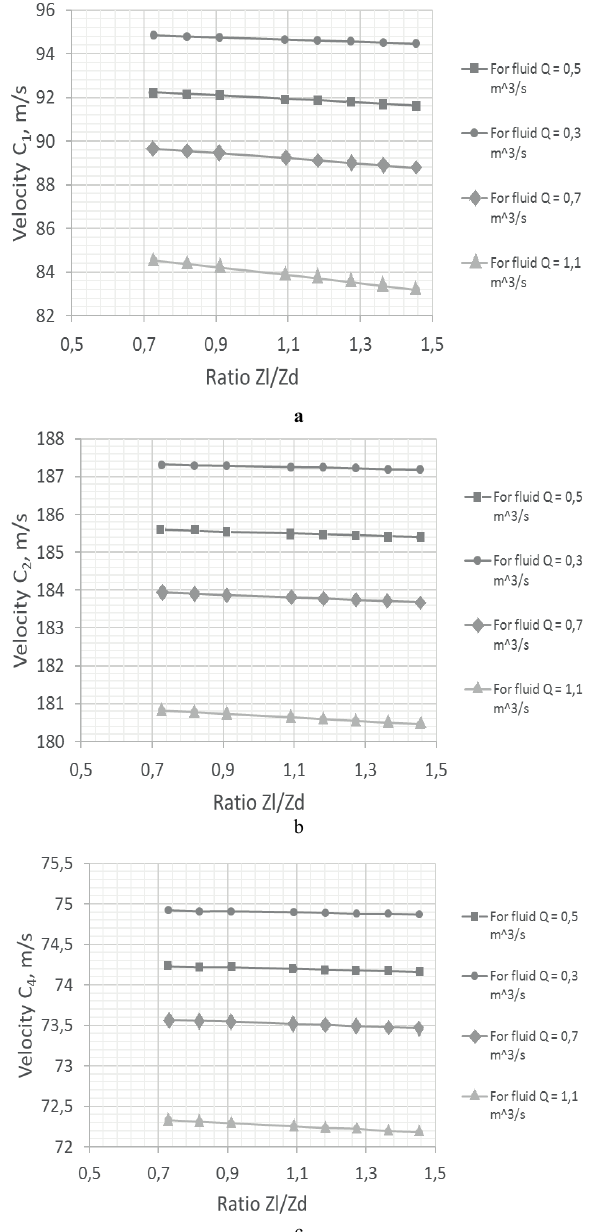
c Fig. 8. Dependences of the gas velocities on the ratio of the impeller and the diffuser blades: (a) for the gas velocity at the inlet to the impeller; (b) for the gas velocity between the impeller and the diffuser; (c) for the gas velocity at the outlet of the